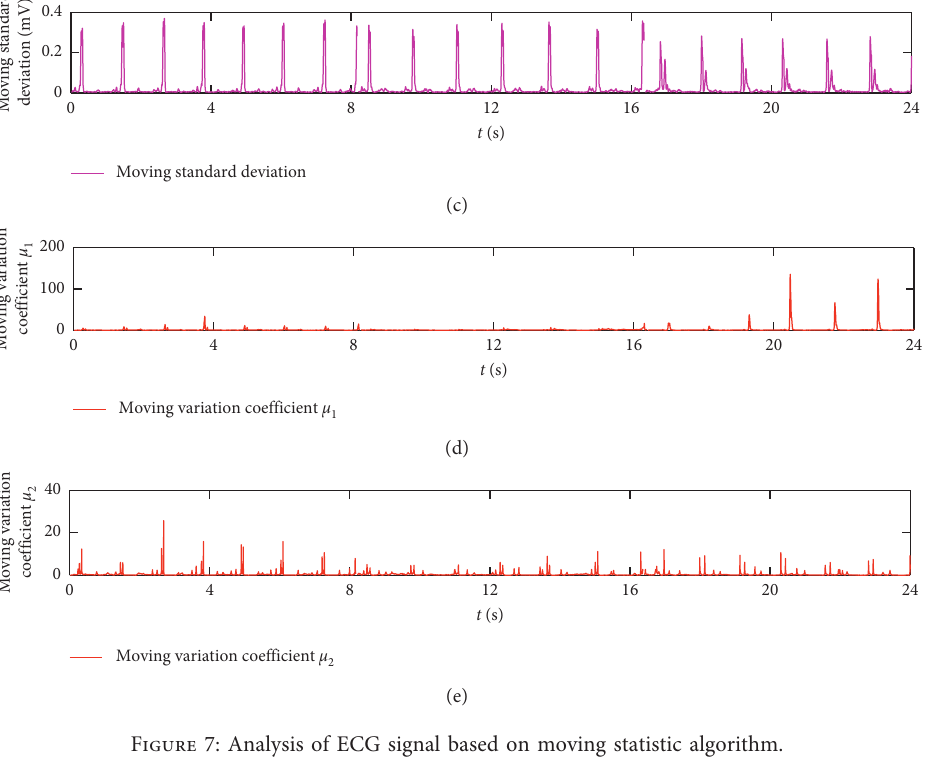
Figure 7: Analysis of ECG signal based on moving statistic algorithm.